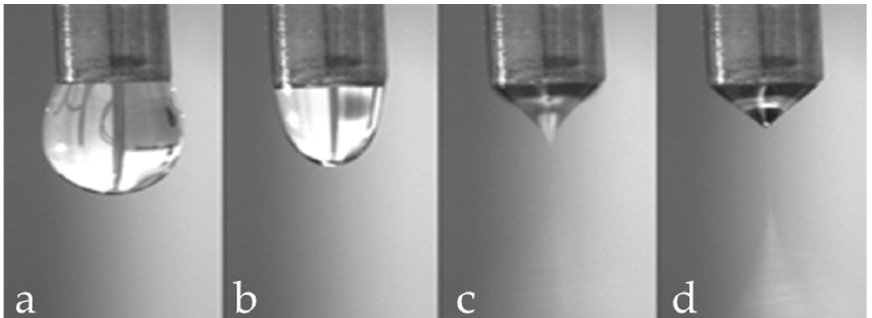
Figure 2. Effect of increasing applied voltage on the shape of the solution drop ejected by the needle: ( a ) normal dripping; ( b ) micro dripping; ( c ) intermittent Taylor cone; and ( d ) Taylor cone jet.